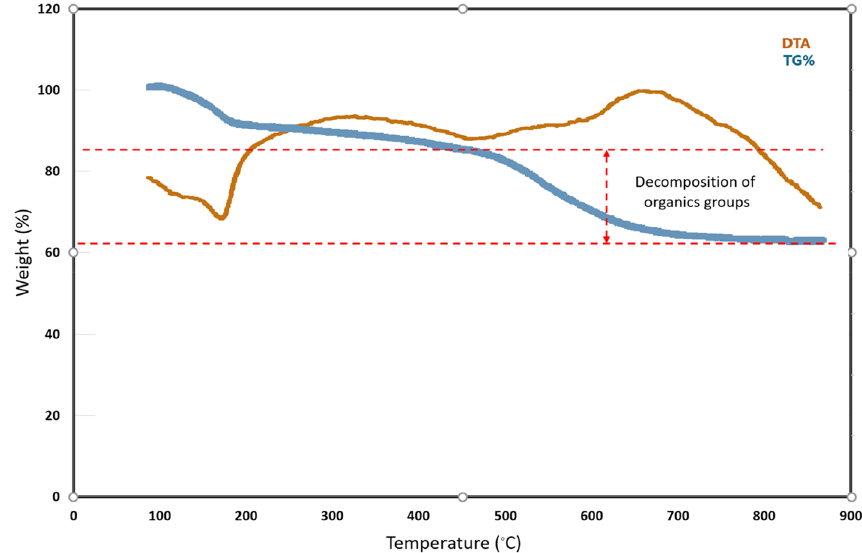
Figure 8. The TGA curves of KCC-1@NH 2